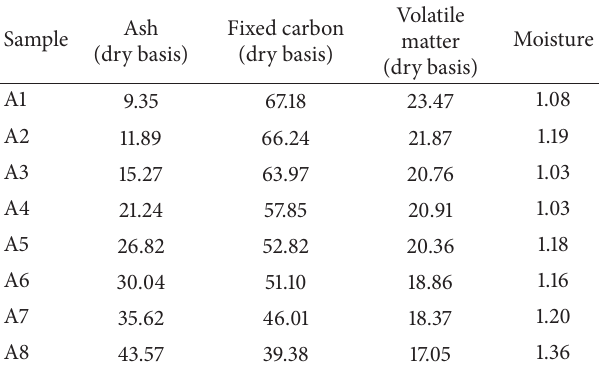
Table 1: Proximate composition analysis of selected coal samples (mass fraction,